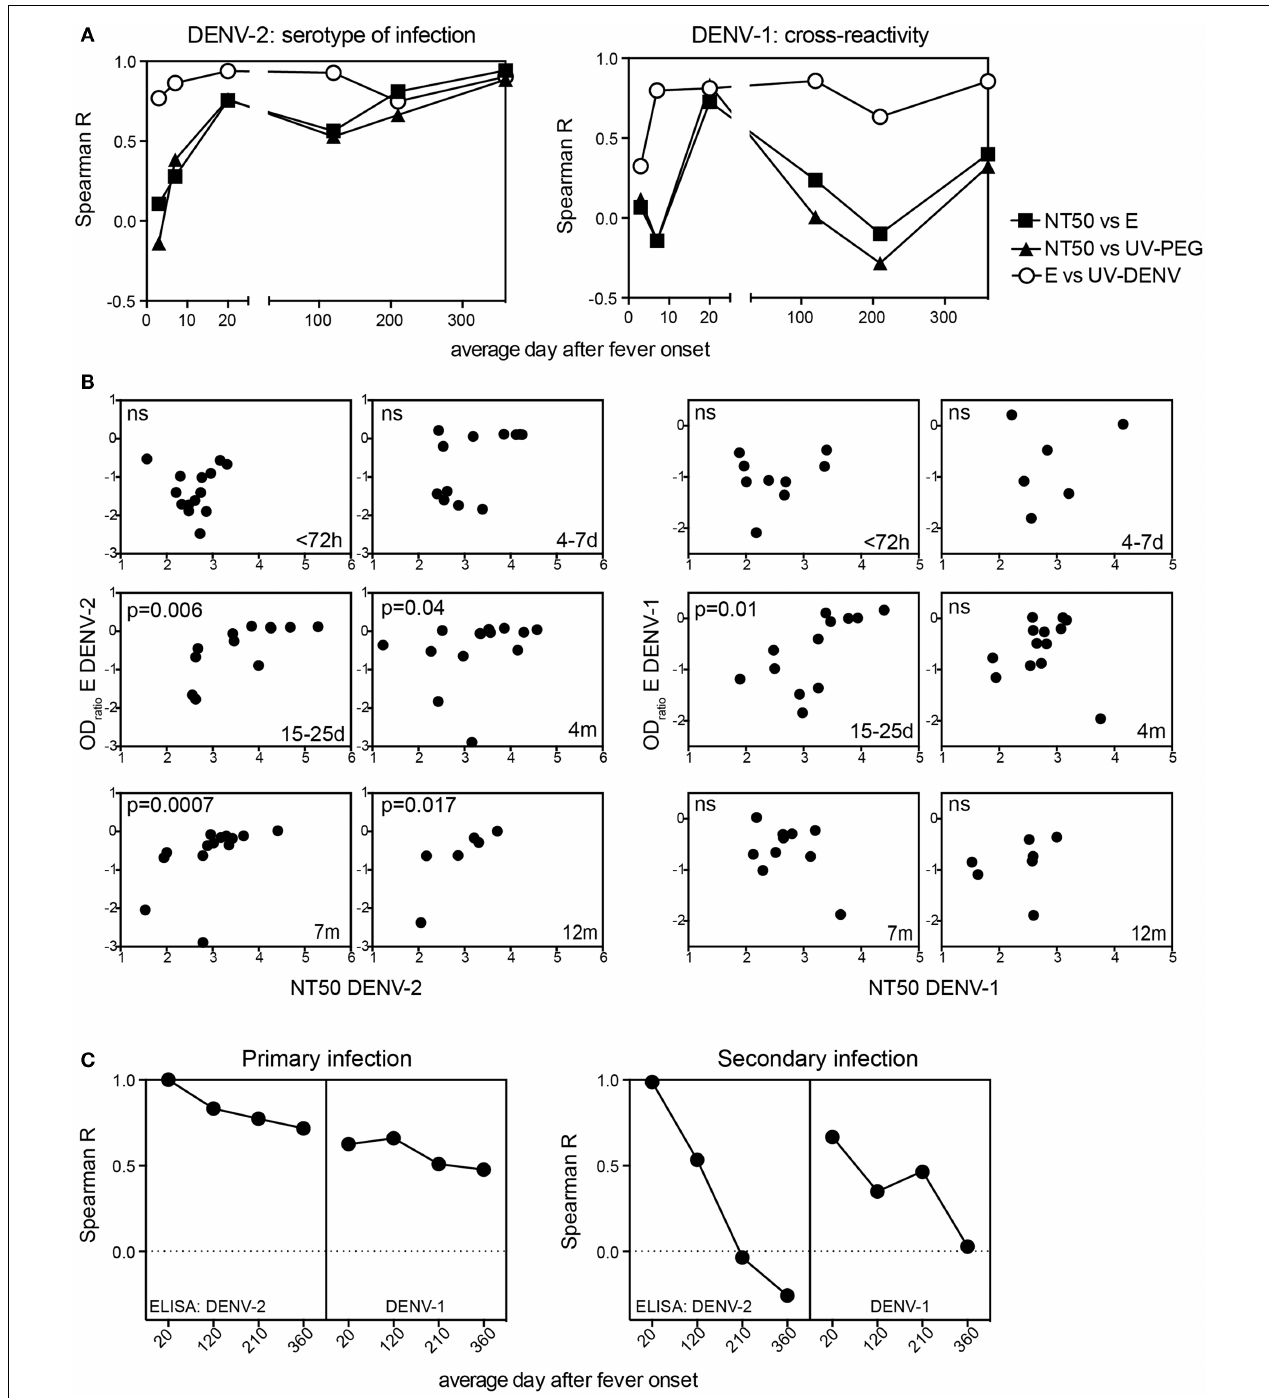
DENV-2 specific antibodies are shown in the graphs on the left and correlations for DENV-1 specific antibodies are shown in the graphs on the right. (C) Correlations between the highly cross-reactive E protein ELISA titer measured at day 15–25 for DENV-2 and the DENV-2 and DENV-1 E protein ELISA titers measured at time points indicated in the x axis were calculated.The correlations were calculated separately for primary and for secondary